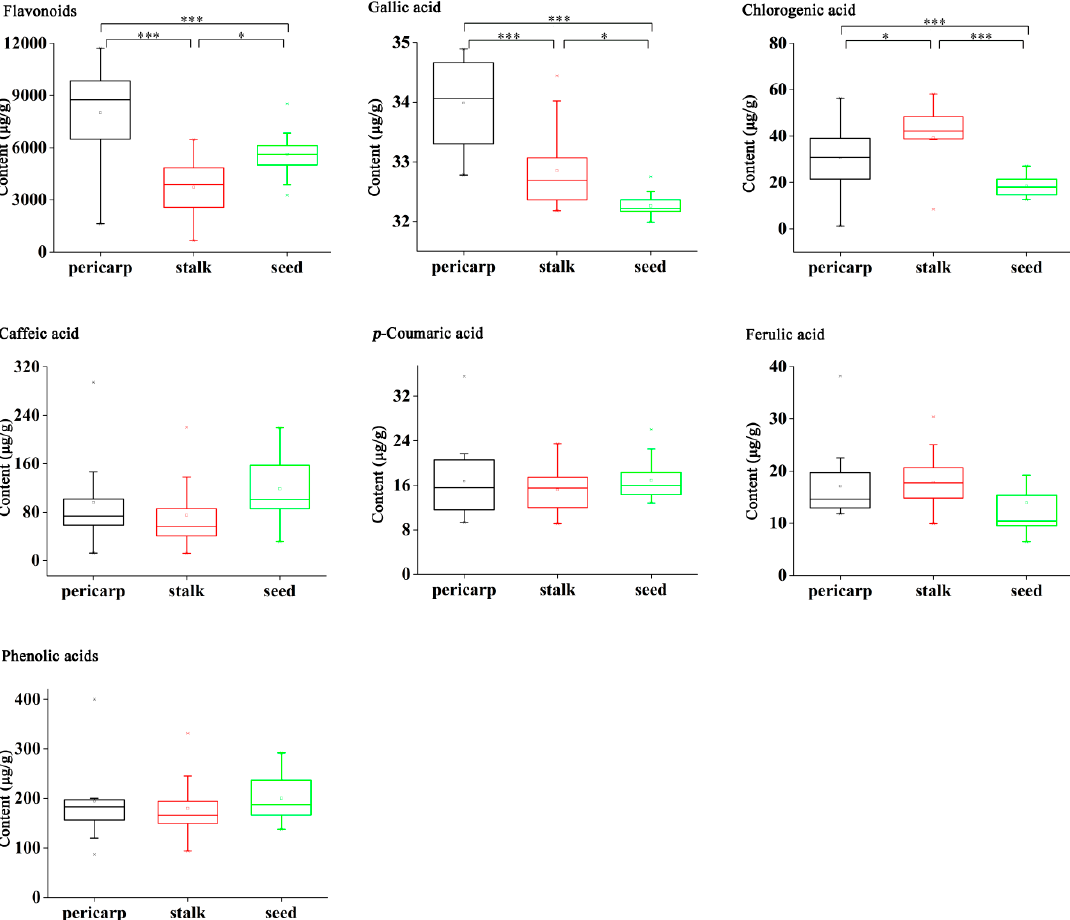
Figure 3. Variance analysis of twenty-one analytes among different segments of Forsythiae Fructus (* p < 0.05; ** p < 0.01; *** p < 0.005).